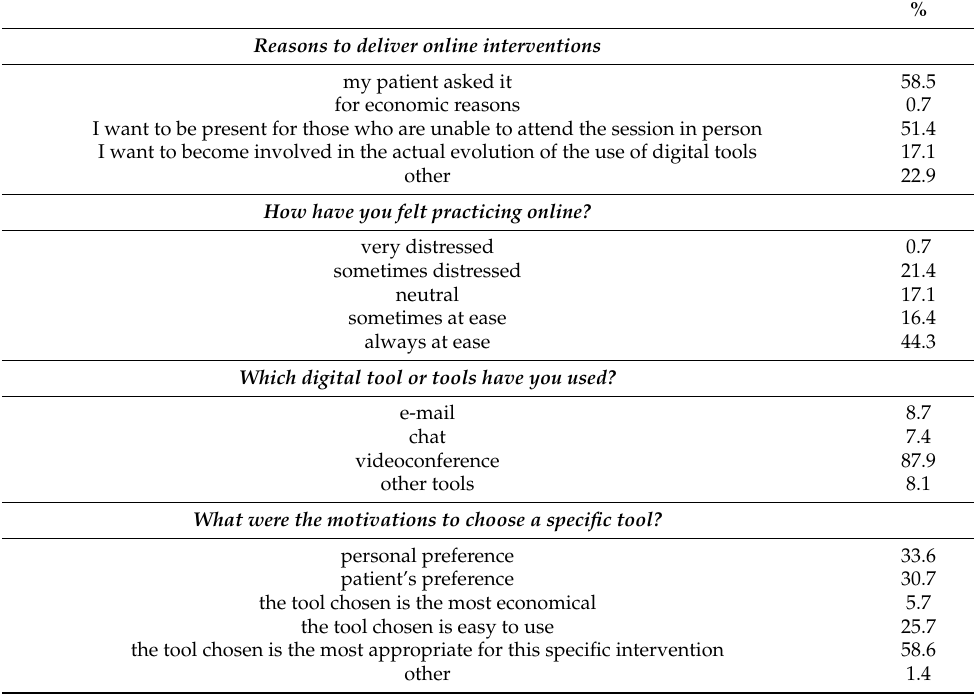
Table 2. Data on those who experienced online interventions before the COVID-19 pandemic.